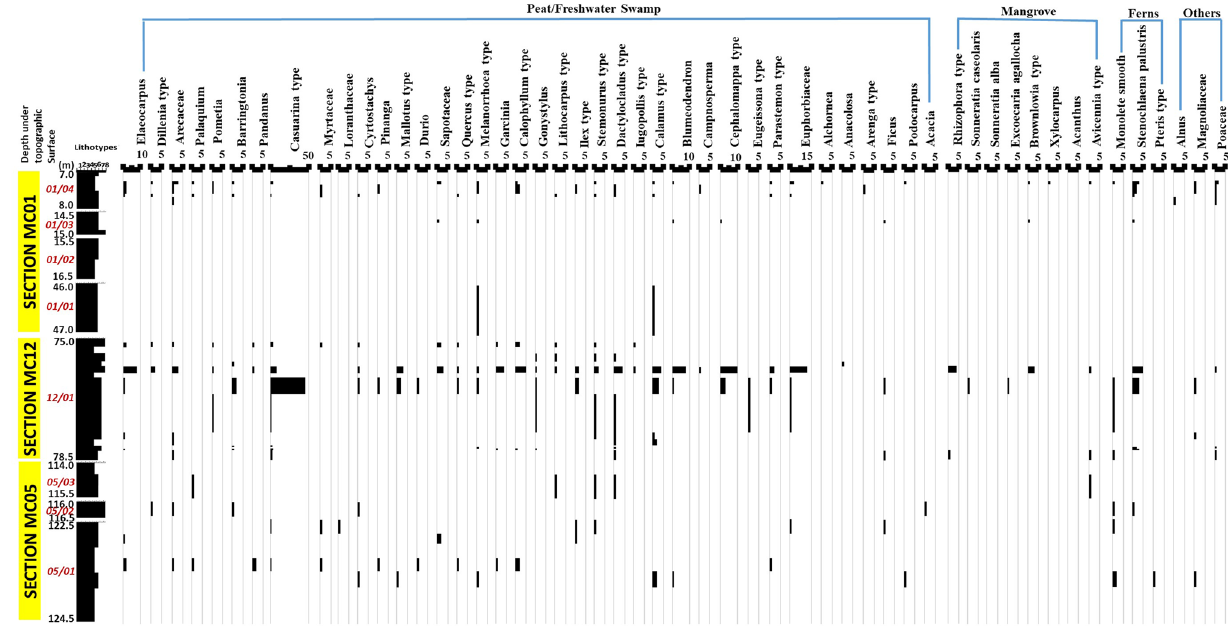
Figure 5. Vertical distribution of different palynotaxas recovered in the Mukah coal samples being studied. The palynomorphs have been grouped into peat/freshwater swamp, mangrove, ferns, and others. The coal lithotypes are also